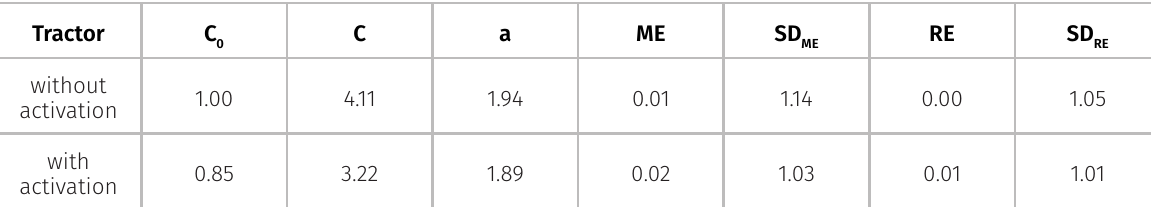
Table II. Estimated parameters of the experimental semivariogram for the noise level emitted by a tractor activation and with activation of a rotary